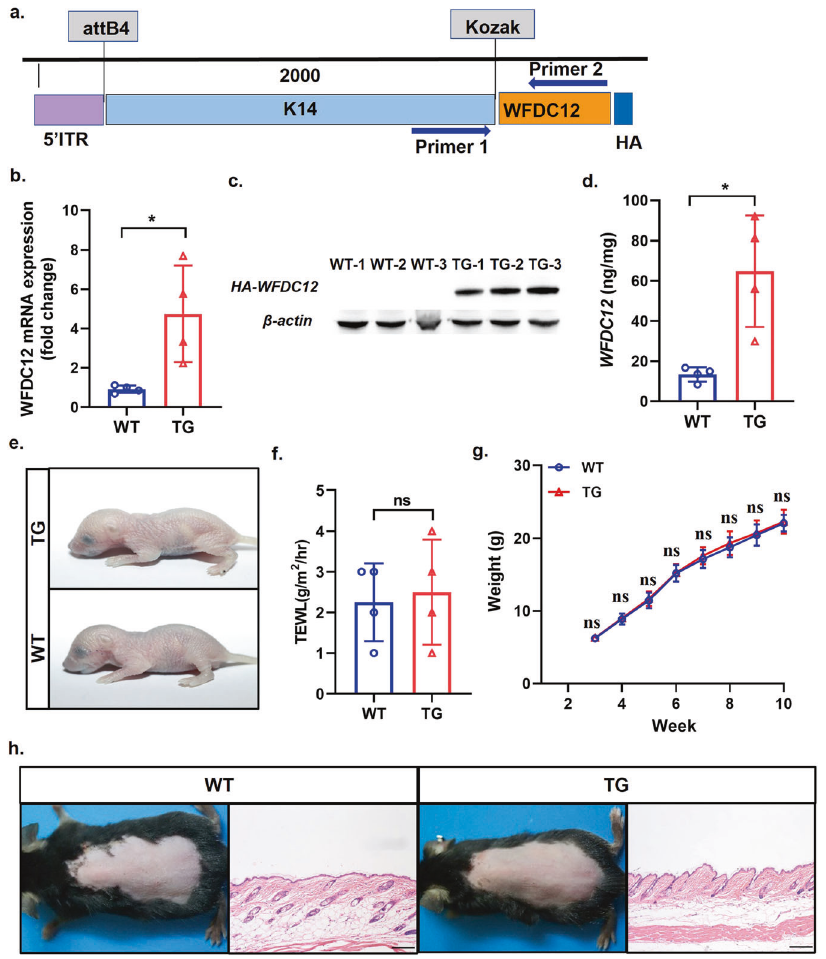
Fig. 2 The transgenic mice with keratinocyte-speci fi c overexpression of WFDC12 (K14-WFDC12) were successfully constructed and the overexpression of WFDC12 did not affect the skin homeostasis and survival of mice. a The construction schematic diagram of K14-WFDC12 plasmid. b RT-PCR analysis was used to detect WFDC12 mRNA levels in WT and TG mice. c The western blot results of dorsal skins of WT and TG by using anti-HA. d ELISA was used to detect the protein expression of WFDC12 in the skin of WT and TG mice. e The toluidine blue staining of fetus mice. f TWEL determination in fetus rats. g Statistical chart of weight change during mouse growth. h Direct view of 8-week- old mice dorsal skin after shaving and H&E staining of paraf fi n sections in skin stable state. Scale bar: 200 μ m. Data were expressed as mean ± SD. Asterisks indicate statistical signi fi cance based on unpaired or paired T -tests. ‘ ns ’ indicates no statistical